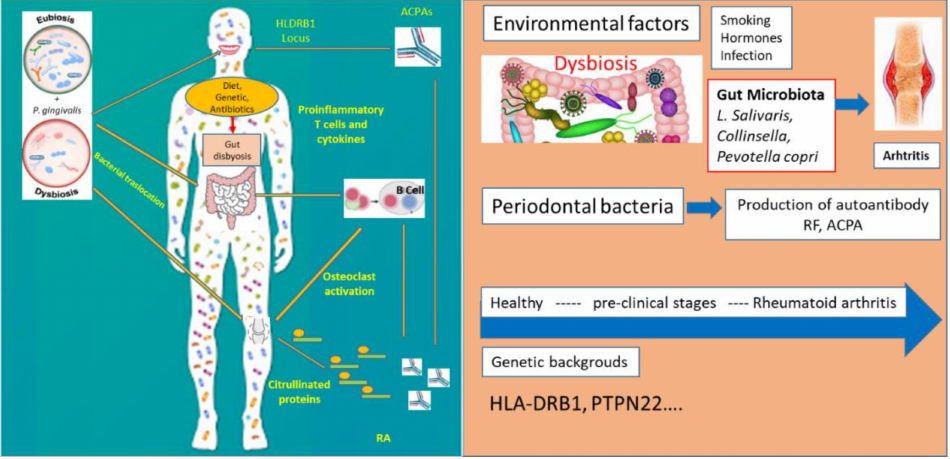
Figure 2. Genetic and environmental factors involved in the pathogenesis of rheumatoid